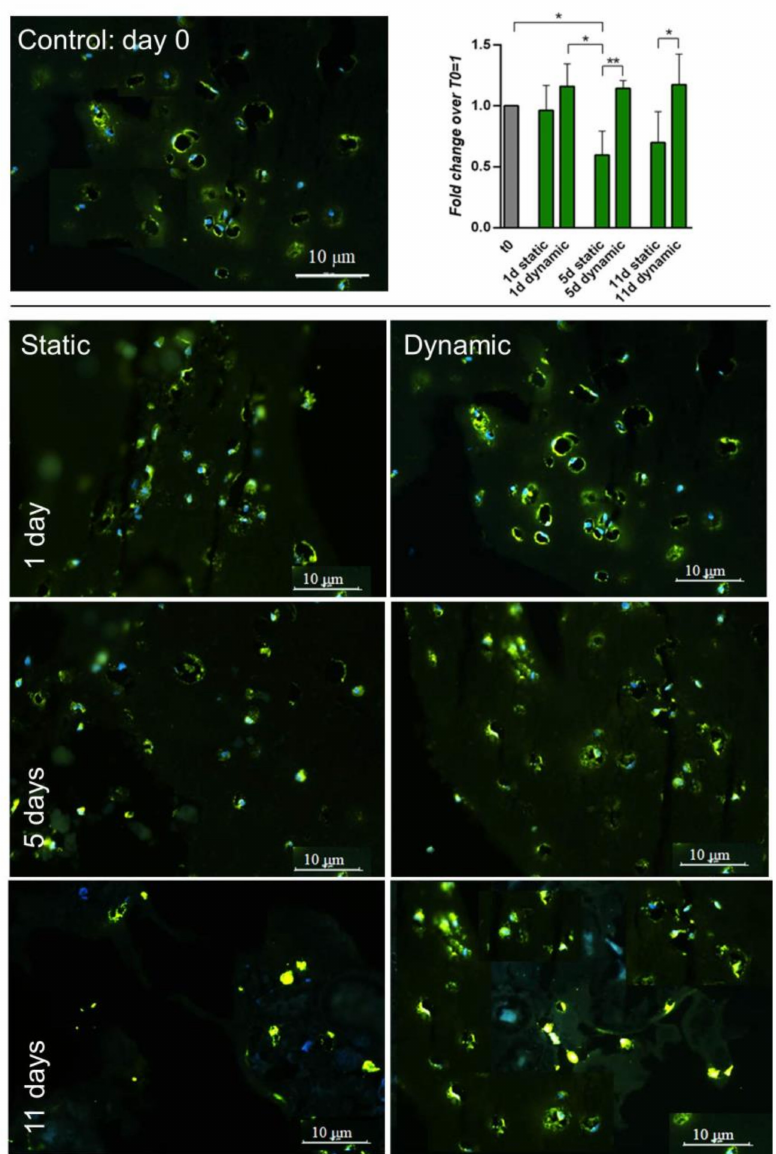
Figure 7. IF and quantitative-IF assays of type 1 Collagen (COL1A1) in 3D static and dynamic2 culture of hBM-MSCs for 11 days. At day 1, holes within the hydrogel structure are evident nearby